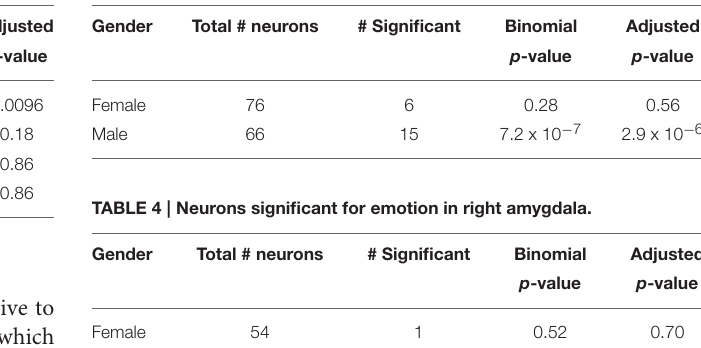
TABLE 2 | Neurons significant for emotion by brain area. TABLE 3 | Neurons significant for emotion in left amygdala.